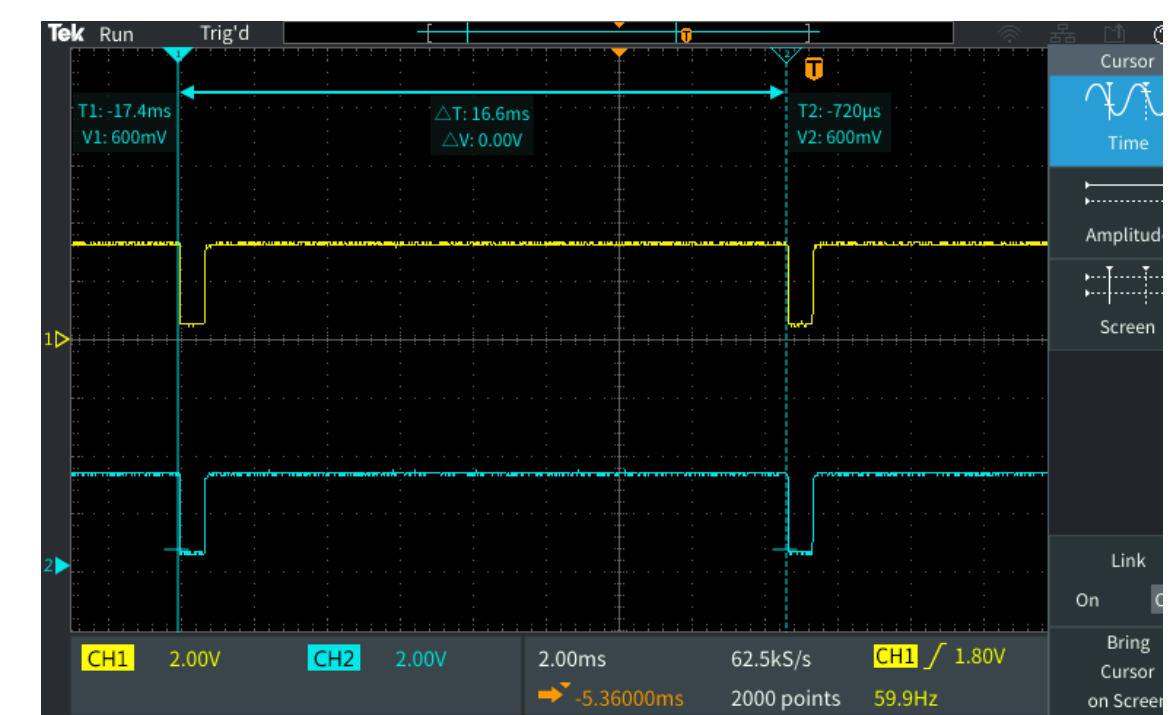
Figure A6. Trigger signal produced by the primary ( yellow ) and received by the secondary ( blue ) cameras.